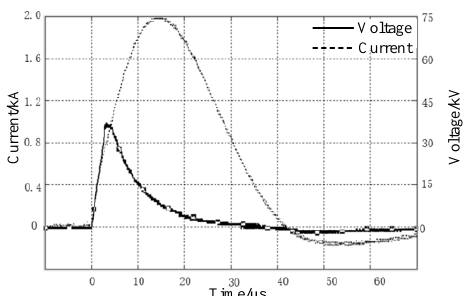
Figure 13. Current and voltage waveform of modified soil with the SAP content of 0.1% when injected into the impulse current.